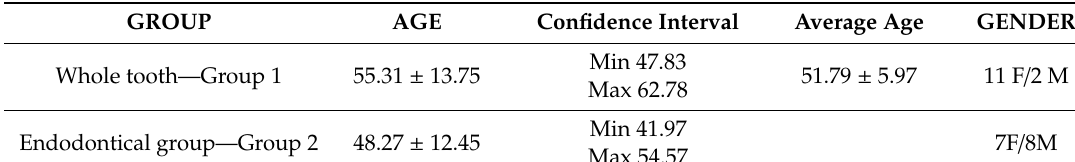
Table 1. Demographic analysis of patients.